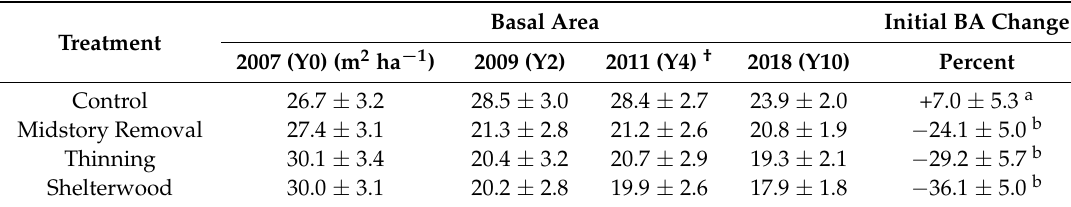
Table 1. Mean ± SE basal area (BA) estimates for silvicultural treatments in each sampling year. Initial BA change was calculated as the percent change between Y0 and Y2 sampling periods for each plot. Therefore, values displayed in the Initial BA Change column reflect means of the percent change in BA, rather than the percent change in the